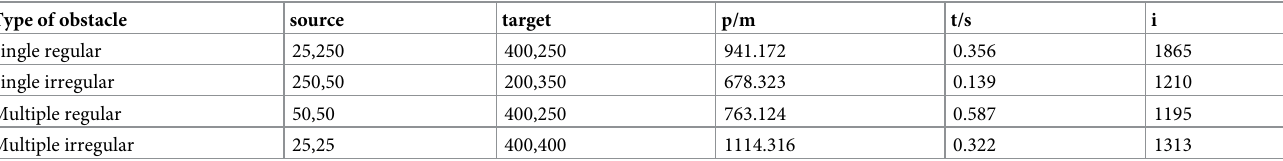
Table 1. Path planning performance of VBAS algorithm under different types of